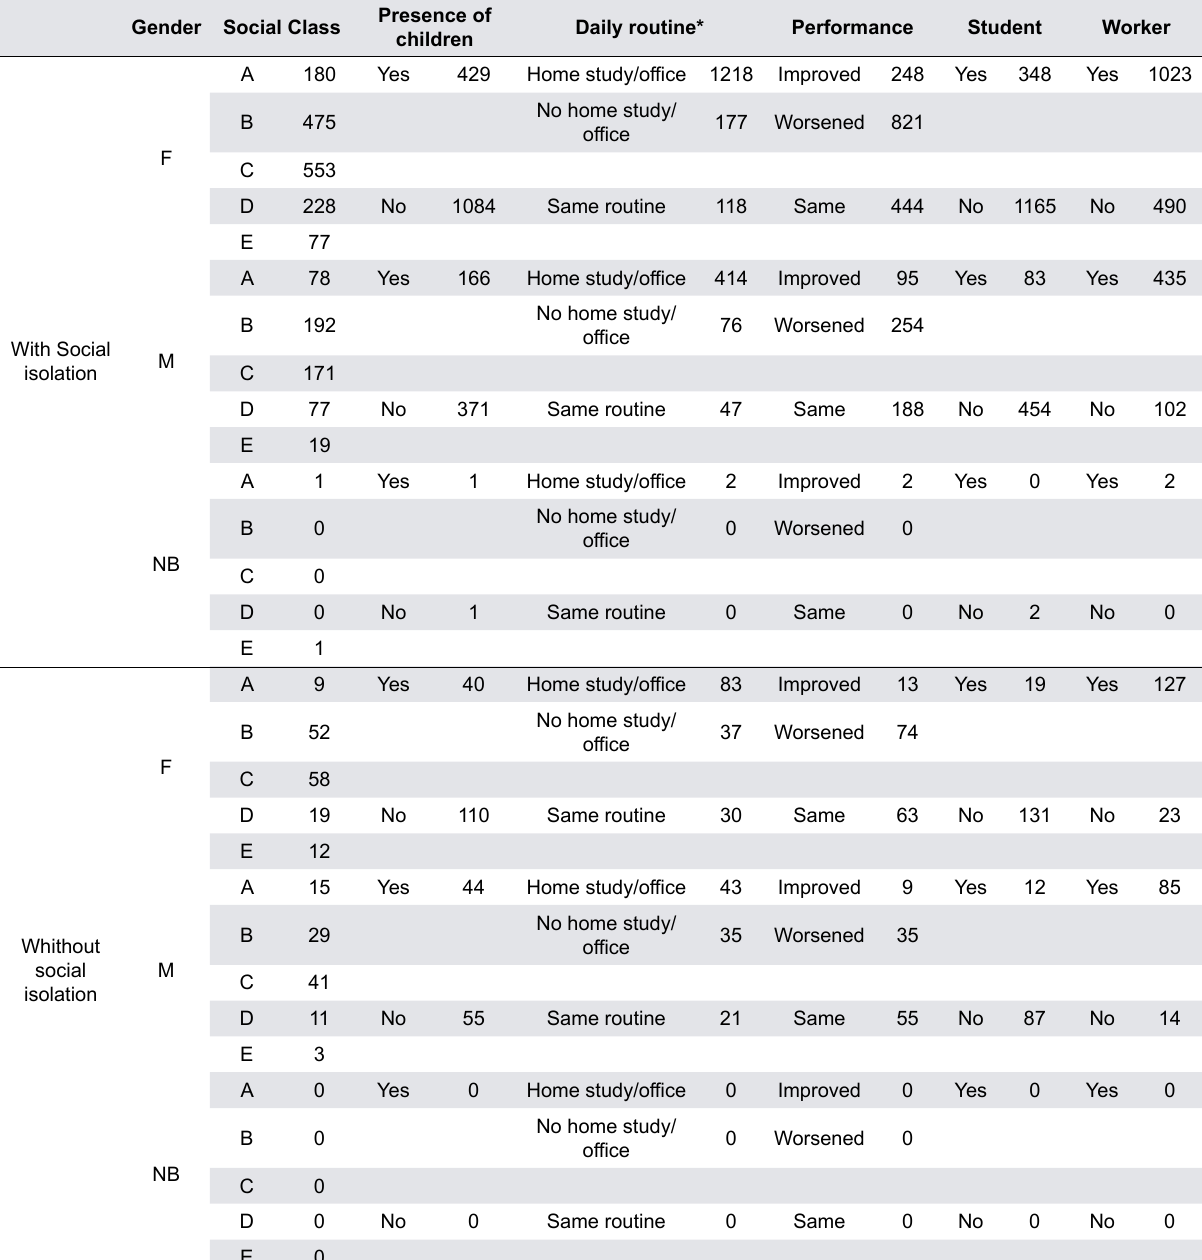
Table 1- Distribution of demographic data according to practice of social isolation and